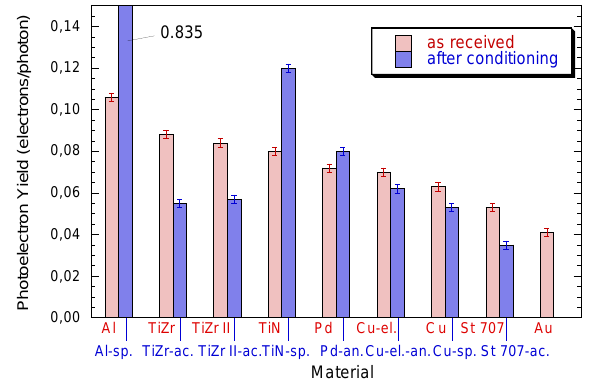
FIG. 14. (Color) The WL PY for the samples in their as- received and conditioned